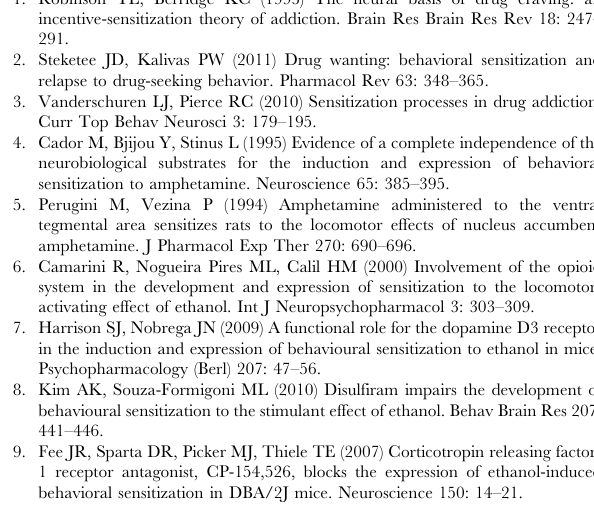
Figure S1 Schematic drawings of mouse coronal sec- tions. The regions of interest for measurement of acetyl-H4K12- and NeuN-positive cells are indicated by hatched areas.